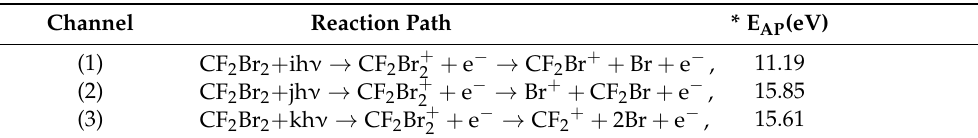
Table 1. The estimated reaction channels and the related energy.